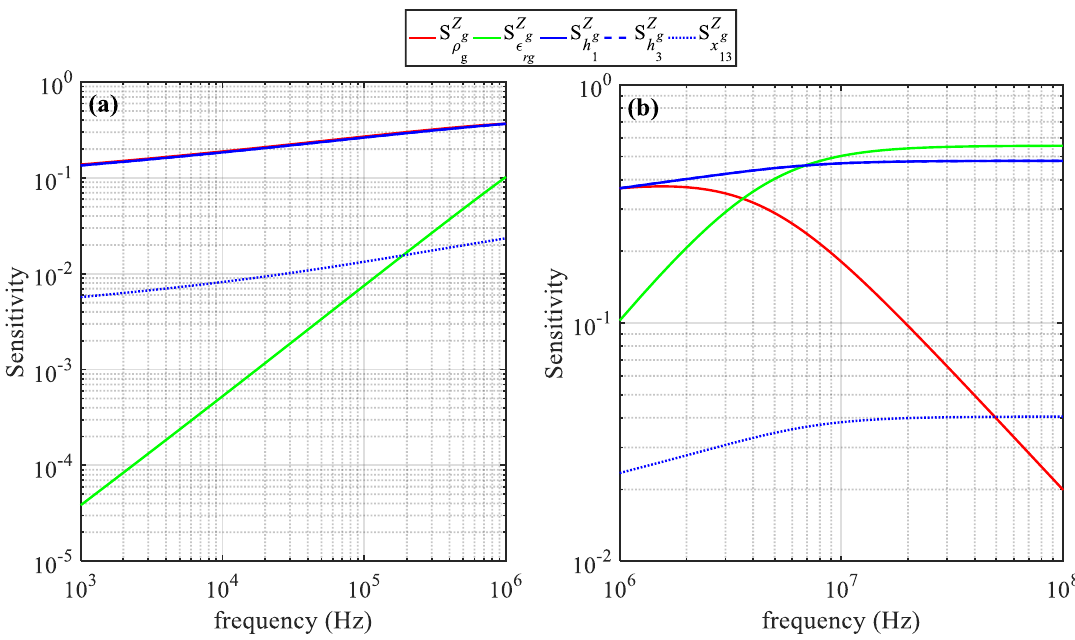
Figure 3. Normalized sensitivities of the mutual impedance for ( a ) narrow-band (NB) and ( b ) broad- band (BB).